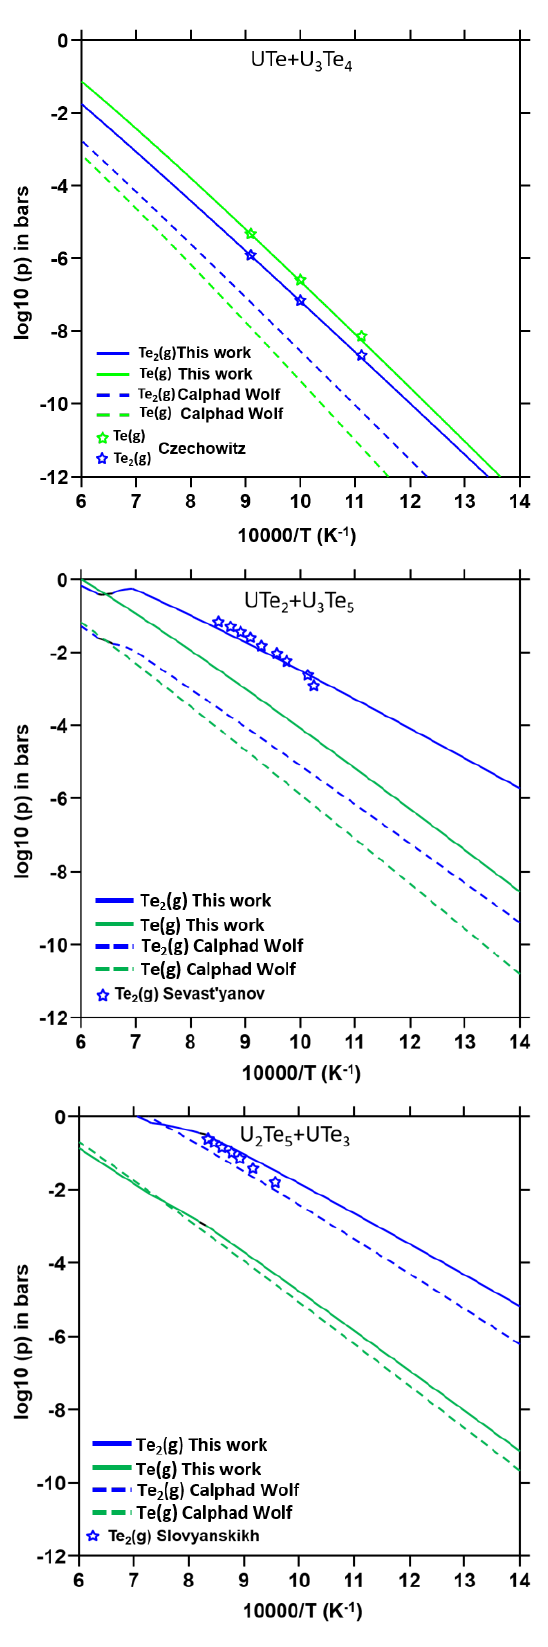
Figure 6. Calculated partial pressure of Te and Te 2 in (UTe + U 3 Te 4 ), (U 3 Te 5 + UTe 2 ), and (U 2 Te 5 + UTe 3 ) in plain lines. Comparison with the experimental results in [22,27,28], and the model of Wolf [20] in dotted